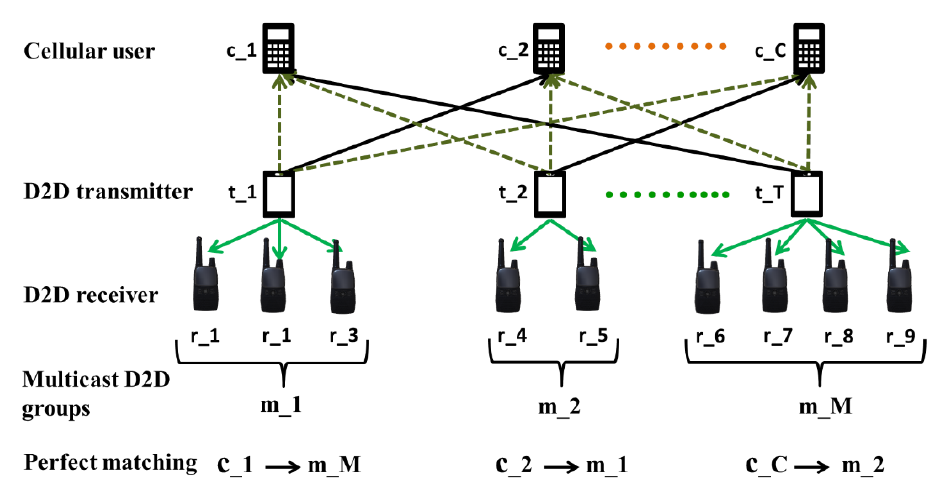
Figure 3. Selection of resource reuse matching between conventional cellular users and multicast D2D groups.